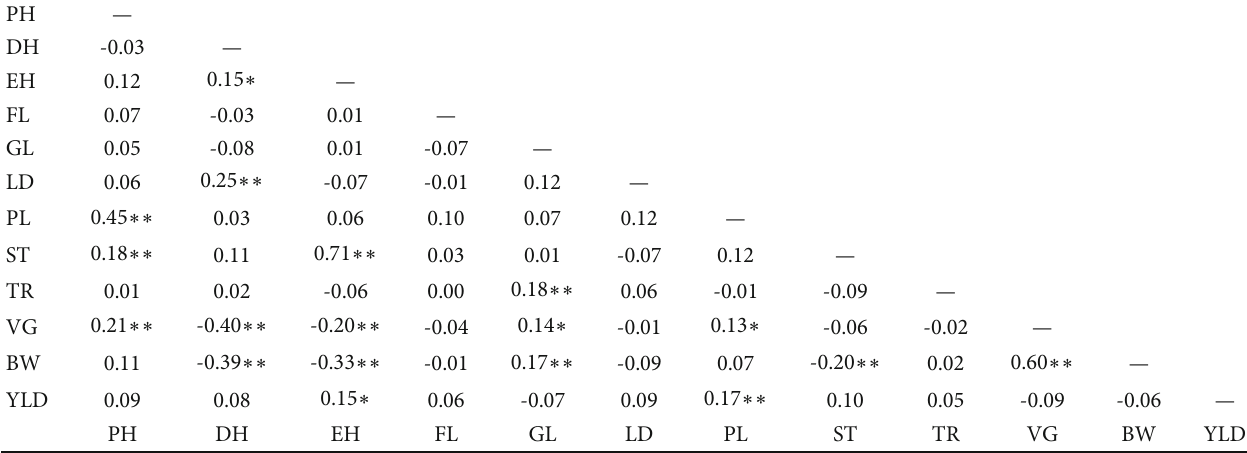
Table 9: Correlation coe ffi cients between B. fusca damage and agro-morphological traits at Embu site. PH